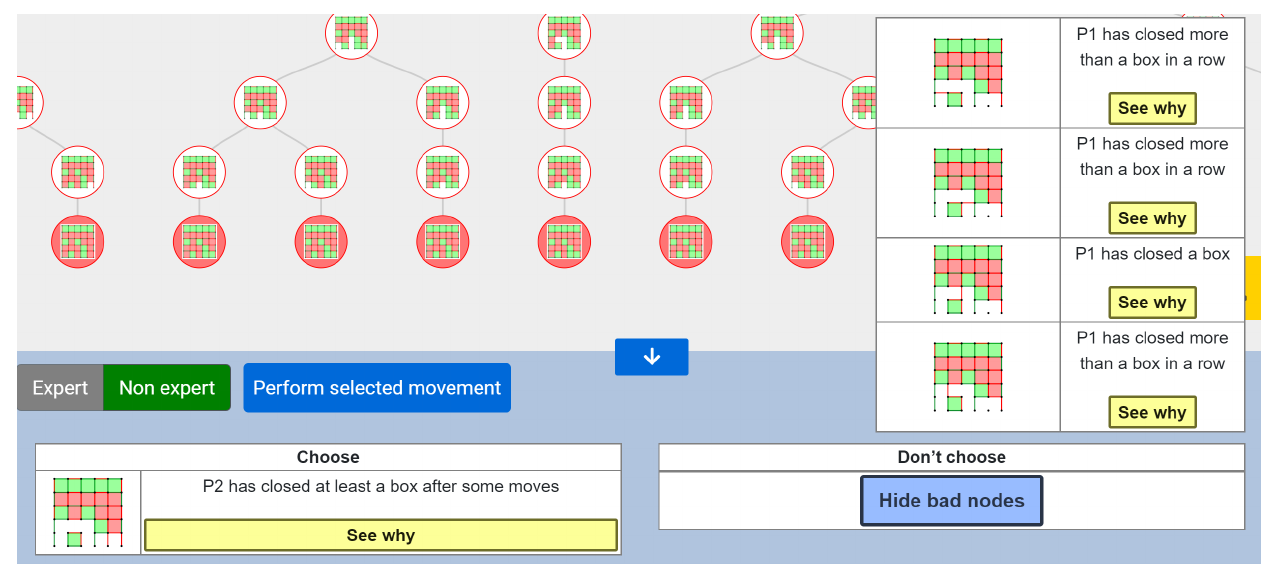
Figure 3. Recommended and not advisable nodes for P2 displayed in the Non-Expert mode. In the case no player closes any box along the path, the reference the system takes is the ratio of victory percentage multiplied by the number of visits. Phases 1 and 2 include moves with immediate rewards or penalties. These are the easiest to identify and correspond to Capture phase of the Steps Method. Phases 3 and 4 are between Capture and Temporal phase because their objective is to close as many boxes as possible but by using several moves, requiring to explore different moves and the influence they have on the board situation the rival or themselves will find after those moves. However, it is easier to identify than the next phase, because the boxes are closed in a row. Finally, phase 5 corresponds to Temporal, the reward is not immediate and requires a sequence of moves, as a box can be sacrificed to somehow trap or obligate the rival to later let you close a bigger number of squares. A strategy where the player performs several moves without pay-off leading to a closed box, is part of this fifth phase too. These two strategies are clearly related to the Temporal phase in the Steps Method, as they require understanding of the need to perform various movements to achieve a final